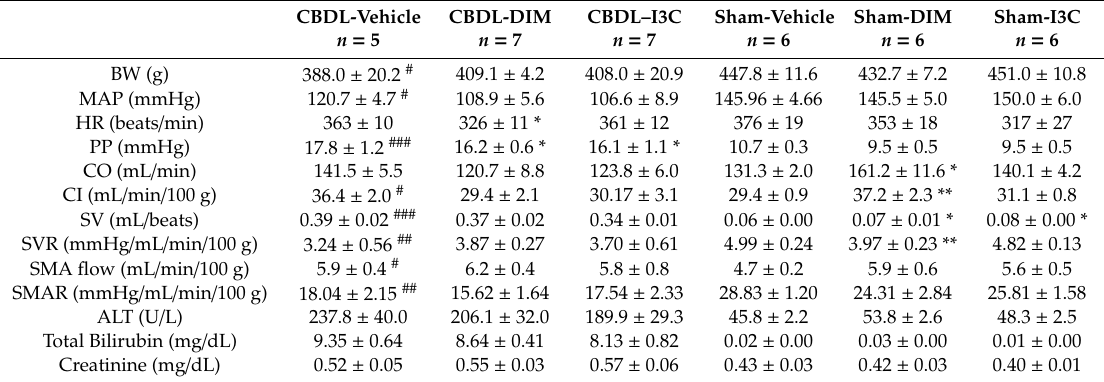
Table 1. Body weight, hemodynamic parameters, and biochemical markers in CBDL (common bile duct ligation)-induced cirrhotic rats and sham rats with vehicle, DIM, or I3C treatment.